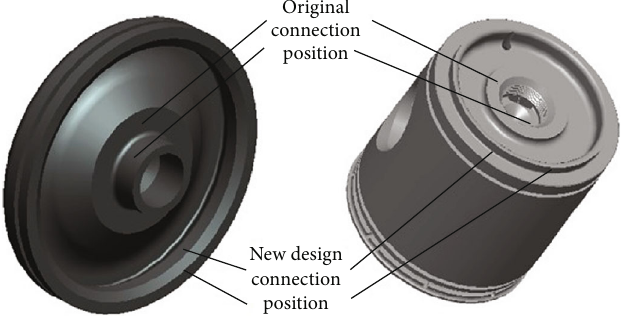
Figure 13: Original design and new design for connection position.